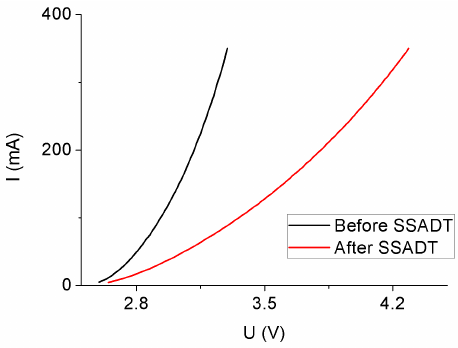
Figure 8. Current-voltage curves of the 5000 °K samples before and after SSADT.